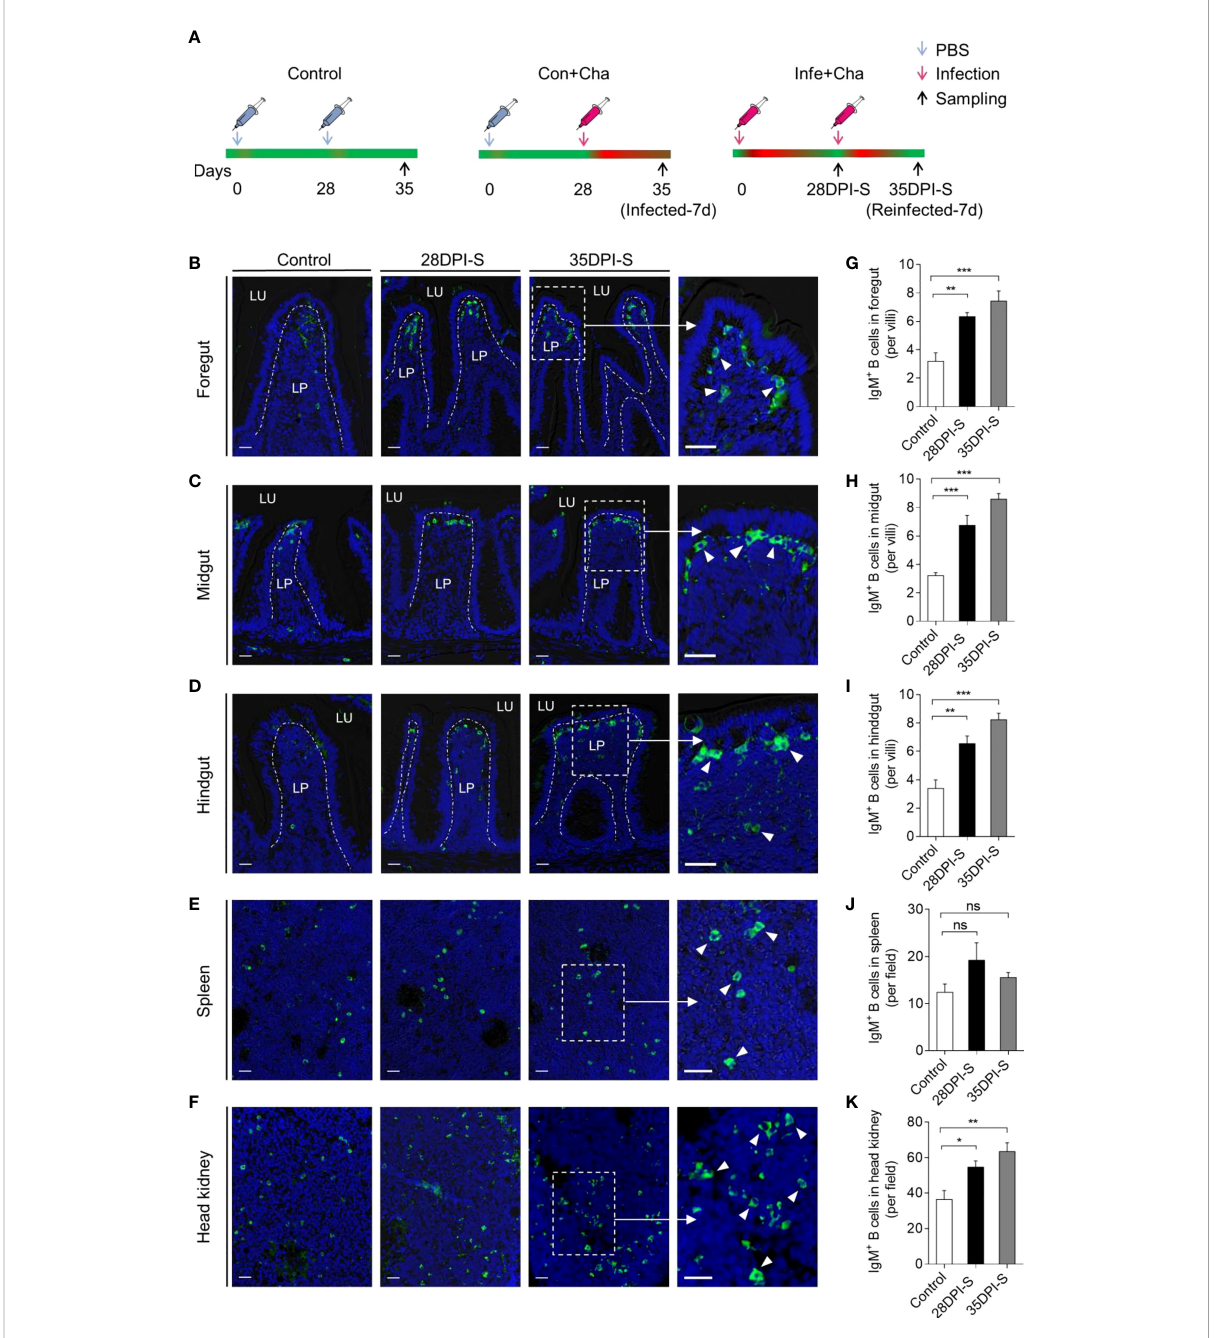
FIGURE 4 Scheme of the reinfection strategy and accumulation of IgM + B cells of common carp infected with A. hydrophila . (A) Scheme of the rechallenge strategy with A. hydrophila via intraperitoneal injection. Fish were injected with A. hydrophila at 0 days and reinfected at 28 DPI with the same bacterial dose, and the resulting surviving fi sh were sacri fi ced at 28 and 35 days after the primary infection (28 DPI surviving group, [28DPI-S]) and 35 (35 DPI surviving group, [35DPI-S]). The three groups of fi sh include Control (PBS + PBS), Con+Cha (PBS + A. hydrophila ), and Infe+Cha ( A. hydrophila + A . hydrophila ). (B – F) Representative differential interference contrast (DIC) images of immuno fl uorescence staining on common carp foregut (B) , midgut (C) , hindgut (D) , spleen (E) , and head kidney (F) paraf fi n-sections from uninfected (Control) fi sh, 28DPI-S, and 35DPI-S fi sh, stained for IgM (green) (Isotype-matched control antibody staining is shown in Figure S1A); nuclei (blue) were stained with DAPI (blue). Scale bars, 20 m m. (G – K) The number of IgM + B cells of Control, 28DPI-S, and 35DPI-S fi sh counted from (B – F) ( n = 6). ns, not signi fi cant, * P < 0.05, ** P < 0.01, and *** P < 0.001 (unpaired Student ’ s t -test). Data are representative of at least three independent experiments (mean ±